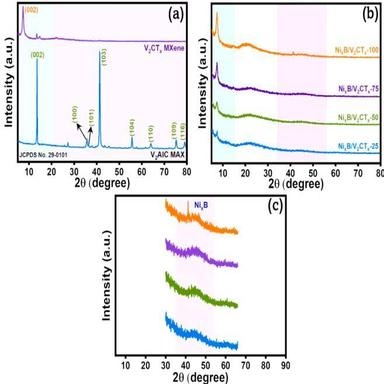
Powder and thin film-XRD patterns of (a) V2AlC and V2CTx, (b) the NixB/V2CTx composites with different concentrations of V2CTx in NixB, and (c) enlarged selected view of figure (b).